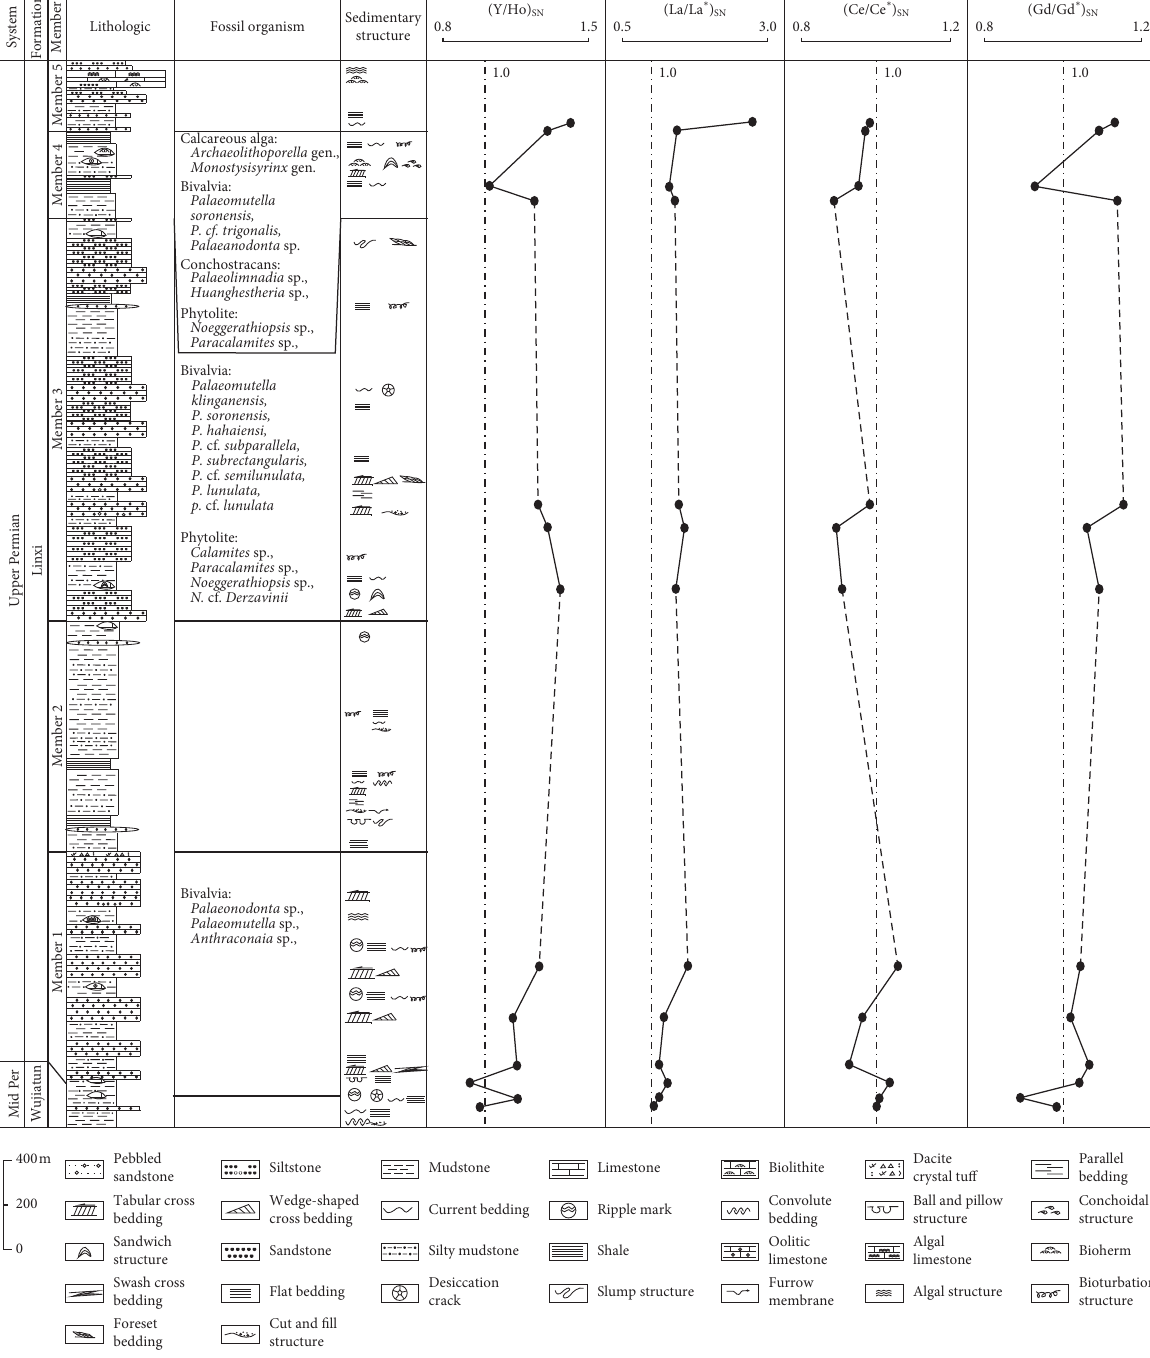
Figure 5: The vertical distribution characteristics of shale-normalised REE+Y of Linxi Formation in the Linxi